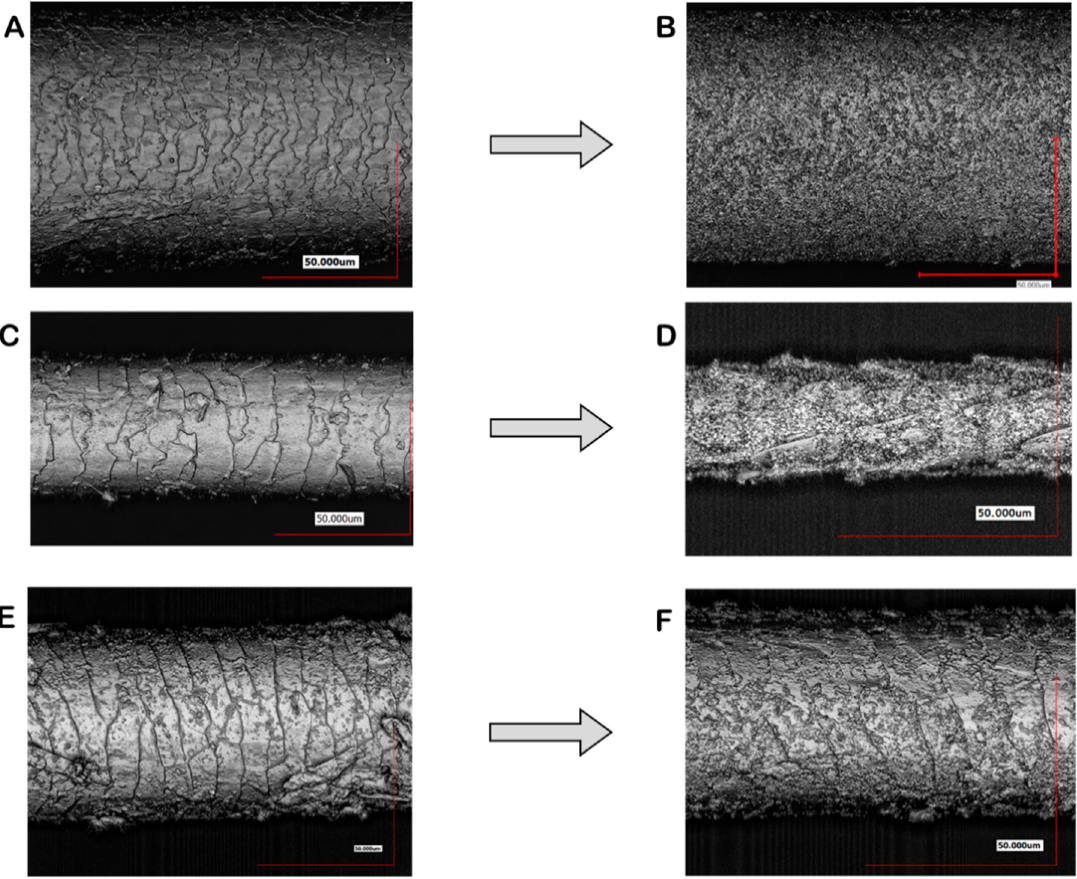
Figure 6. Clay nanotube coating for animal hairs. Bare and coated confocal microscopic images of dog ( A , B ), cat ( C , D ), and horse ( E , F ) hair.